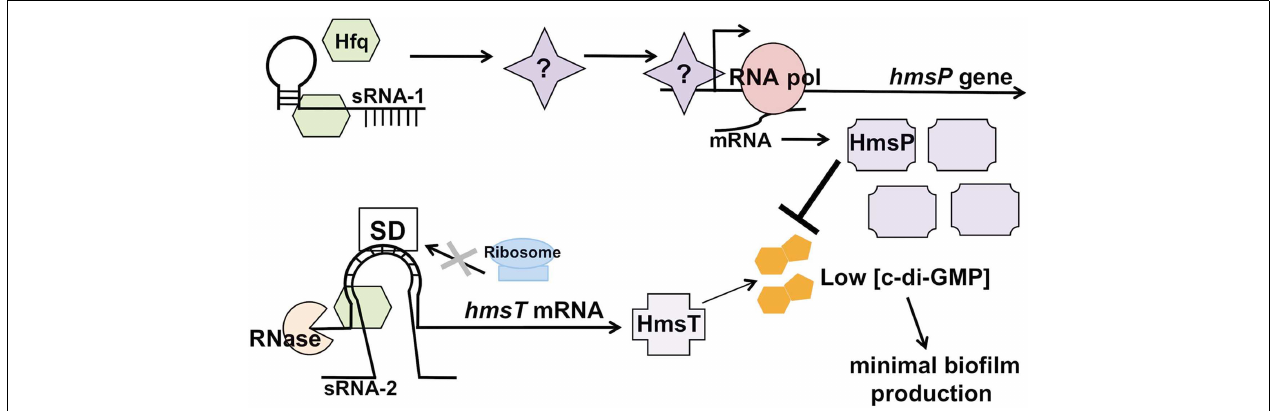
FIGURE 3 | Hfq-dependent regulation of biofilm formation in Yersinia pestis . Hfq, in conjunction with one or more hypothetical sRNAs, is predicted to indirectly affect transcript levels of hmsP by either increasing the levels of a transcriptional activator or by decreasing levels of a repressor, thereby stimulating the synthesis of the c-di-GMP phosphodiesterase